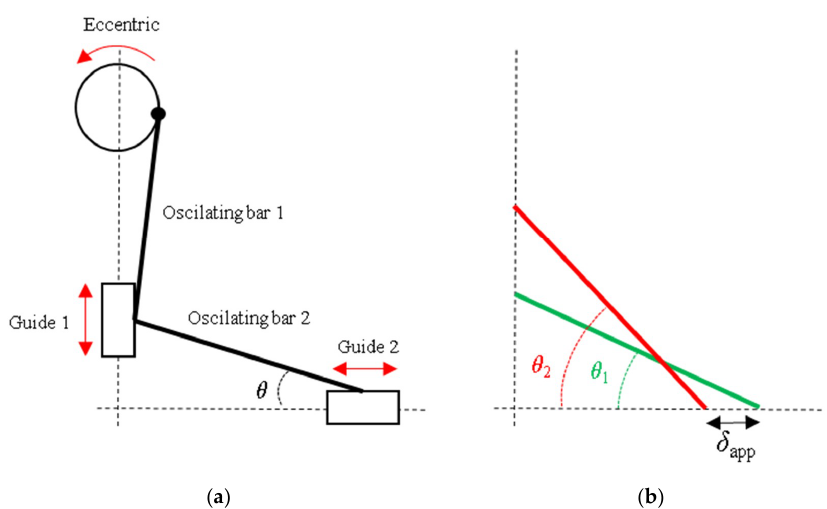
Figure 4. ( a , b ) Sketch of the camshaft mechanism designed for the tribotester displacement.